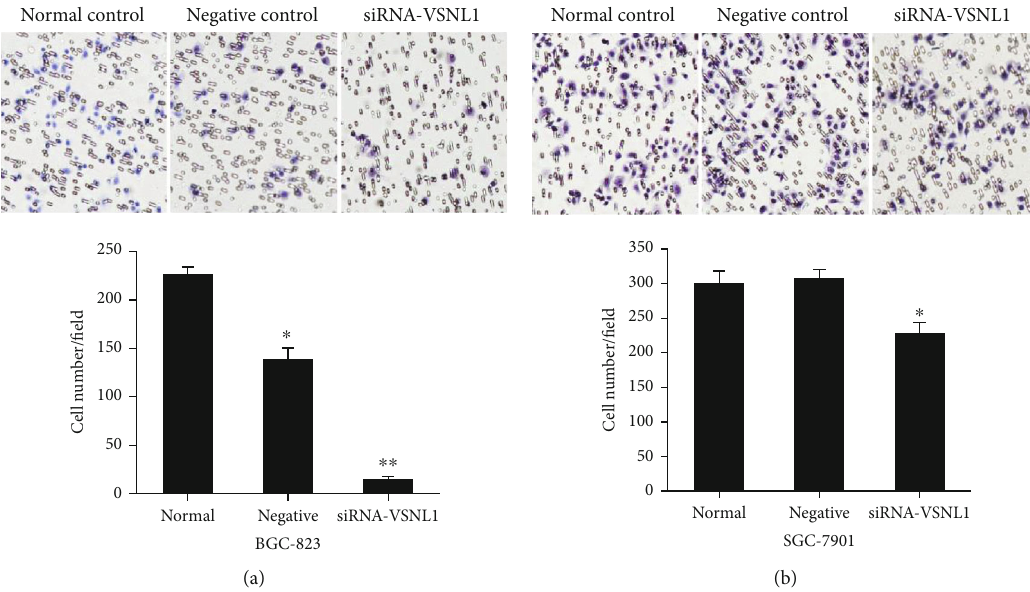
Figure 6: The e ff ect of VSNL1 on the migration and invasion of GC cells in vitro. (a, b) Migration was inhibited signi fi cantly when VSNL1 was depleted in BGC-823 cells; migration was inhibited slightly when VSNL1 was depleted in SGC-7901